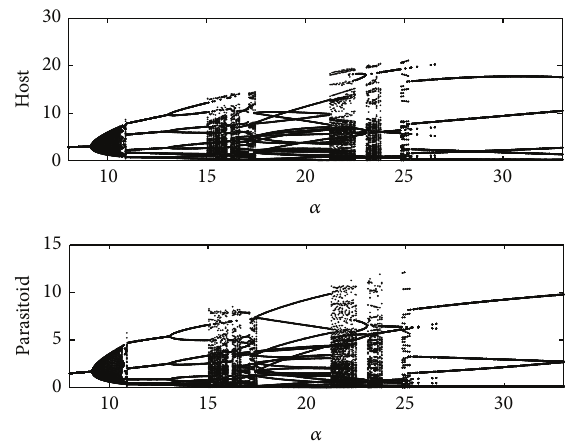
Figure 2: Bifurcation diagrams of model (3). For each 𝛼 the first 1101 simulated values are omitted to remove the initial transients and only the next 100 values are plotted. The host and parasitoid populations are plotted for 500 values of 𝛼 over [8, 34] . The other parameters are fixed as 𝑝 = 0.65 , ET = 7.5 , 𝛽 = 0.5 , 𝜏 = 2 , 𝛼 = 12 , 𝑏 = 1